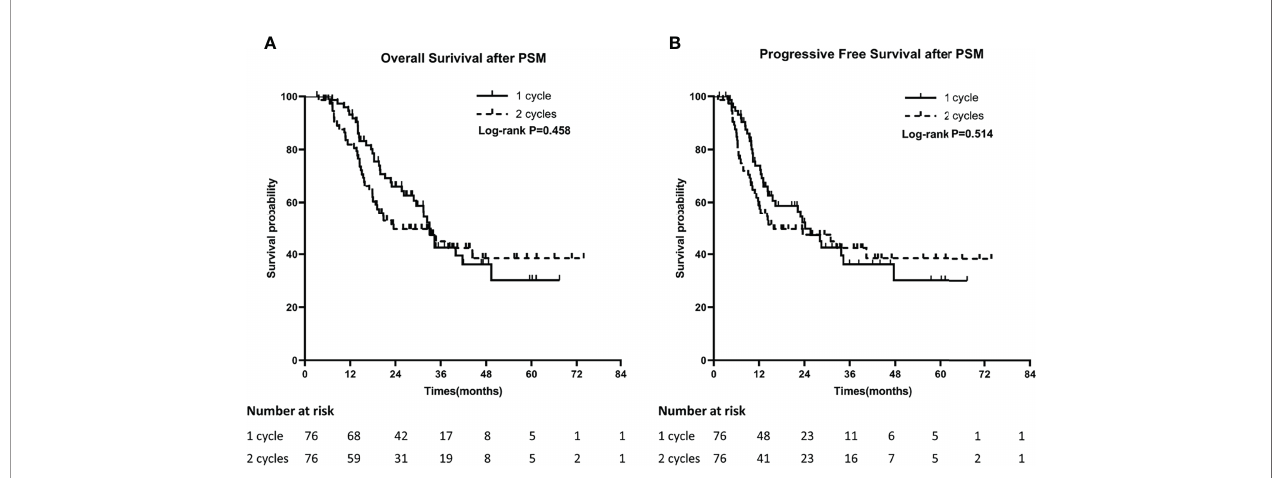
TABLE 3 | Comparison of adverse events in patients with different concurrent chemotherapy cycles. Adverse Events 1 cycle concurrent CRT (98 cases)